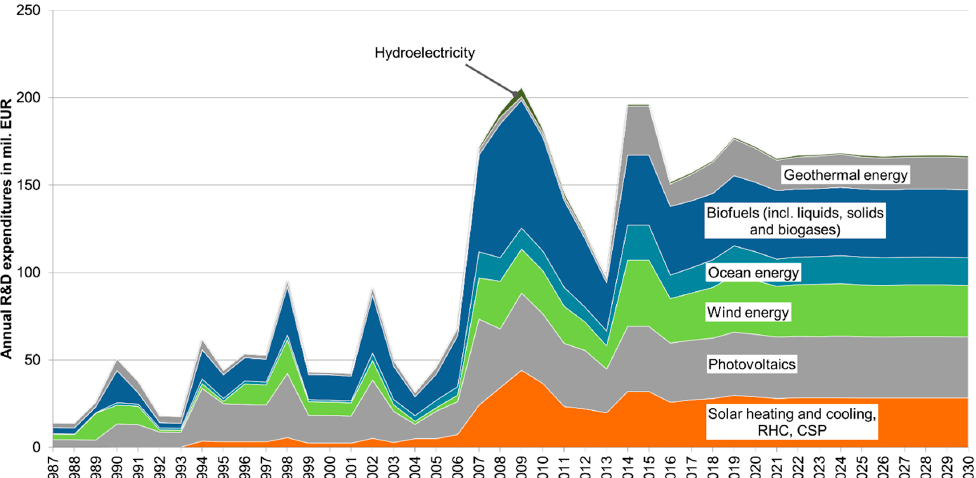
Figure 3. Renewable energy sources R&D expenditures of the EC from 1987 to 2013 and estimated until 2030 (Mil. EUR, BAU scenario) (2014 prices and exc. rates).